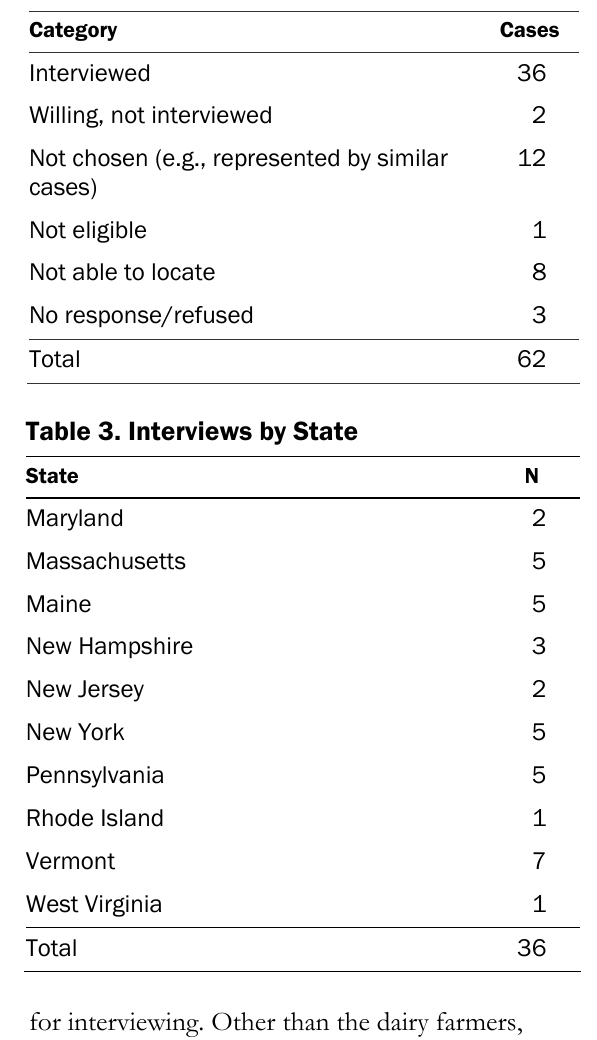
Table 2. Interviews from the Cases Selected from the Completed Surveys